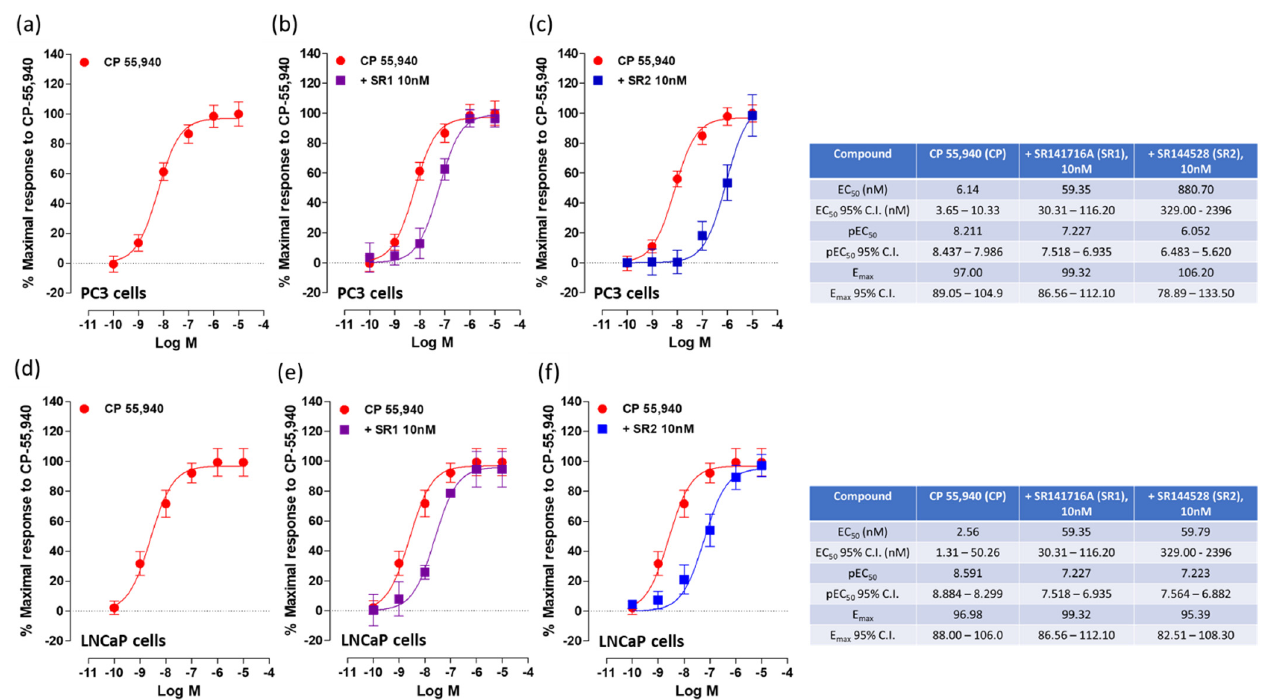
Figure 1. Effects of DIM and CP 55,940 on [ 35 S]GTP γ S in PC3 cell membranes. The effects of CP 55,940 and DIM ( a , d respectively) were also tested in the presence of CB 1 receptor antagonist SR1 ( b , e ) and CB 2 receptor antagonist SR2 ( c , f ). Each data point is the mean percentage value ± S.E.M. ( n = 15). EC 50 , E max and pEC 50 values and 95% confidence intervals are shown in the table. In LNCaP cell membranes, DIM was able to stimulate [ 35 S]GTP γ S binding (EC 50 : 32.06 nM) with less potency compared to CP 55,940 (EC 50 : 2.56 nM) (Figure 2a,d). As shown in